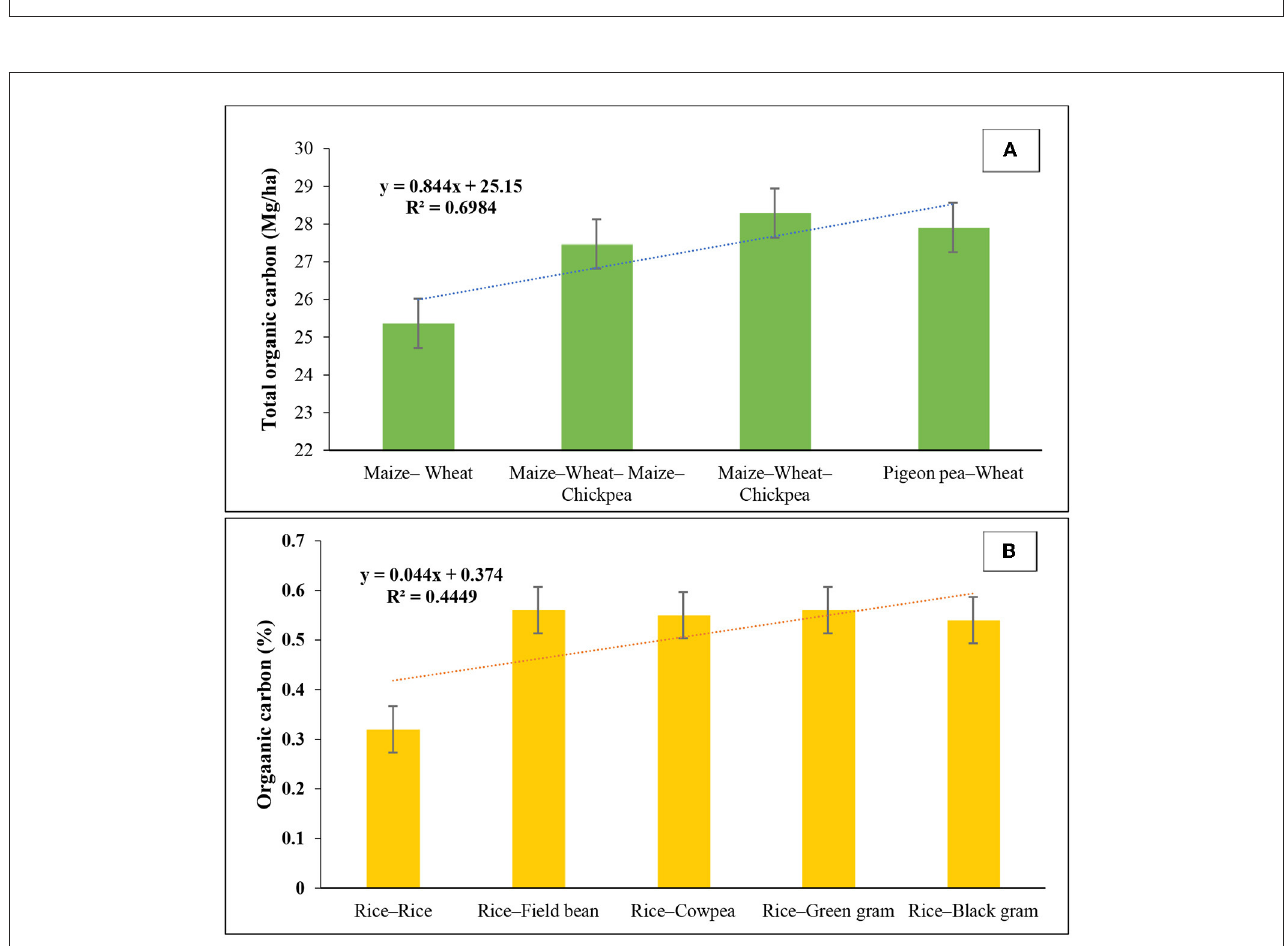
FIGURE6 Effect of pulse-based cropping systems on SOC content. The pulse-based cropping systems have a higher soil C sequestration capacity than mono-cropping systems, (A) Cropping system of maize–wheat–maize–chickpea (27.5Mg ha − 1 ), maize–wheat–chickpea (28.3Mg ha − 1 ), and pigeon pea–wheat (27.9Mg ha − 1 ) improved SOC by 8.3, 11.5, and 10.0% over the maize–wheat system (25.4Mg ha − 1 ) ( y = 0.844x + 25.15; R 2 = 0.6984 ) ( Date source : Venkatesh et al., 2013); (B) The rice–field bean, rice–cowpea, rice–mung bean, and rice–urd bean added 75.0, 71.9, 75.0, and 68.8% more SOC to the soil over rice–rice monoculture ( y = 0.044x + 0.374; R 2 = 0.4449 ) ( Data source : Prakash et al.,